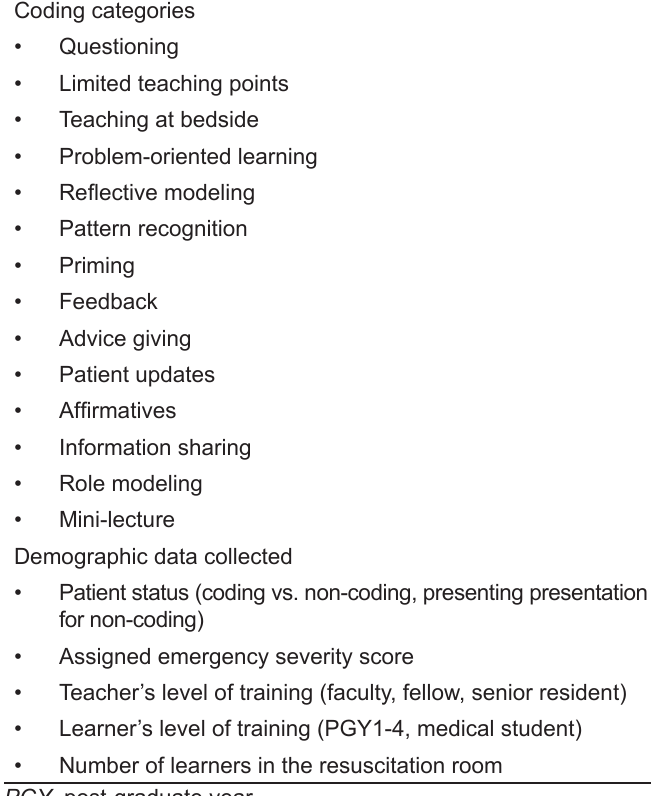
Table 2. Coding categories and demographic data on observation